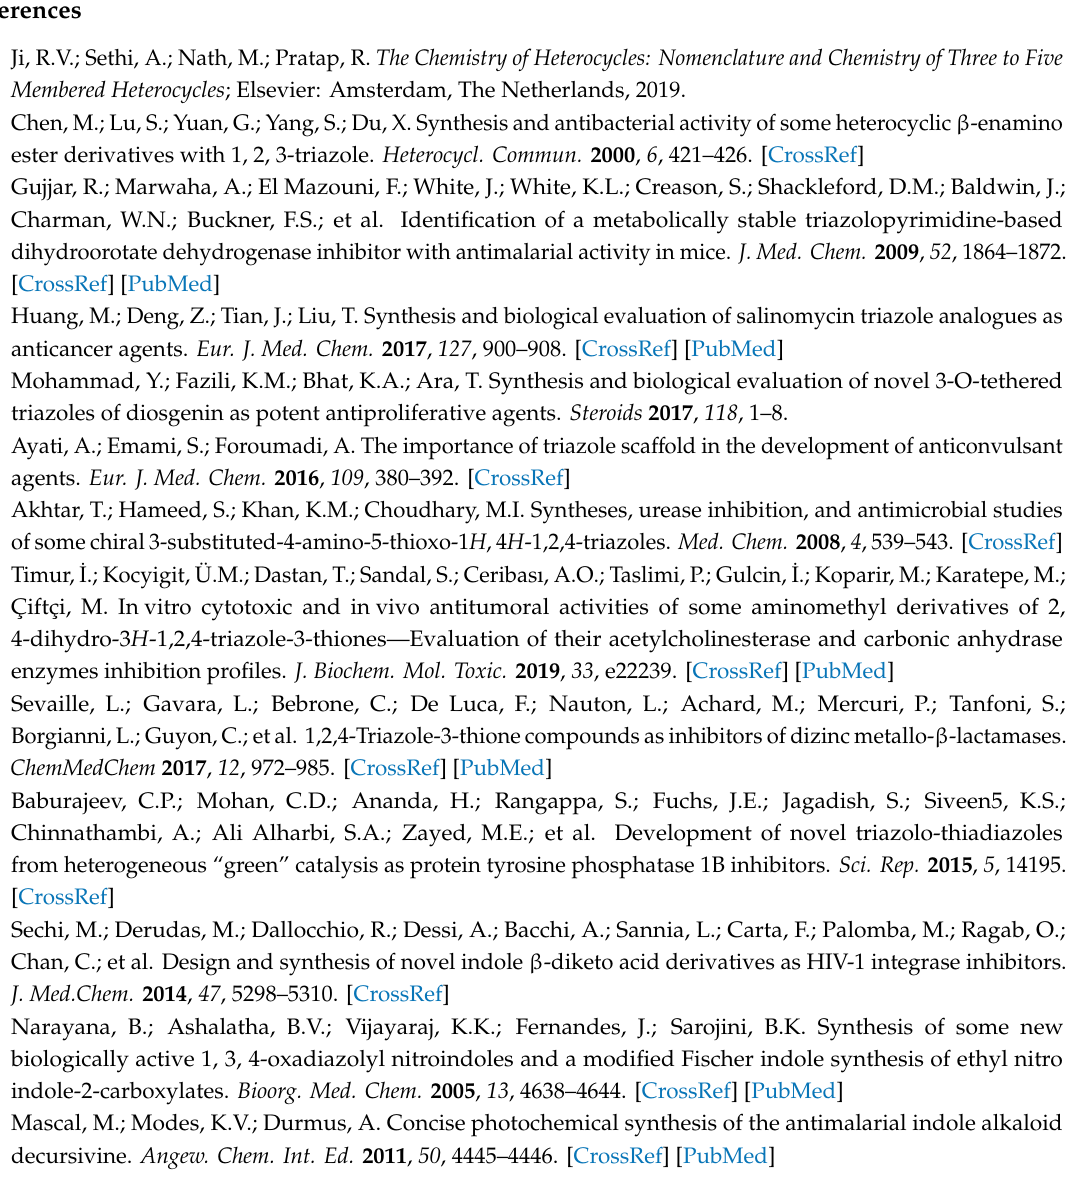
Figure S1: Hirshfeld surfaces of the studied compound; Figure S2: The fingerprint and dnorm of the weak intermolecular contacts in the target compound; Figure S3: Atom numbering of the optimized structure; Table S1 and Table S2: calculated geometric parameters and the calculated and experimental chemical shifts (ppm) of the studied